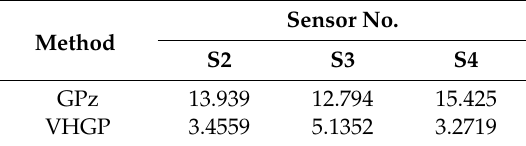
Figure 8. GPz and Variational Heteroscedastic Gaussian Process (VHGP) regression results on laboratory data: ( a ) mean distribution by GPz; ( b ) mean distribution by VHGP; and, ( c ) log-noise distribution by VHGP. Table 1. MSE comparison between GPz and VHGP ( × 10 − 5